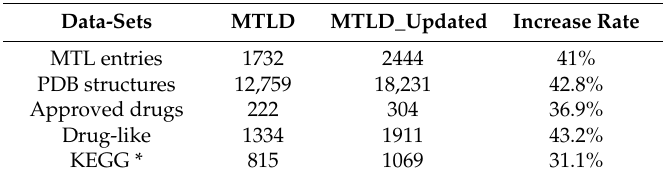
Figure 1. Dataset collection of the MTLD. Table 1. A comparison of the updated MTLD with the previous version of